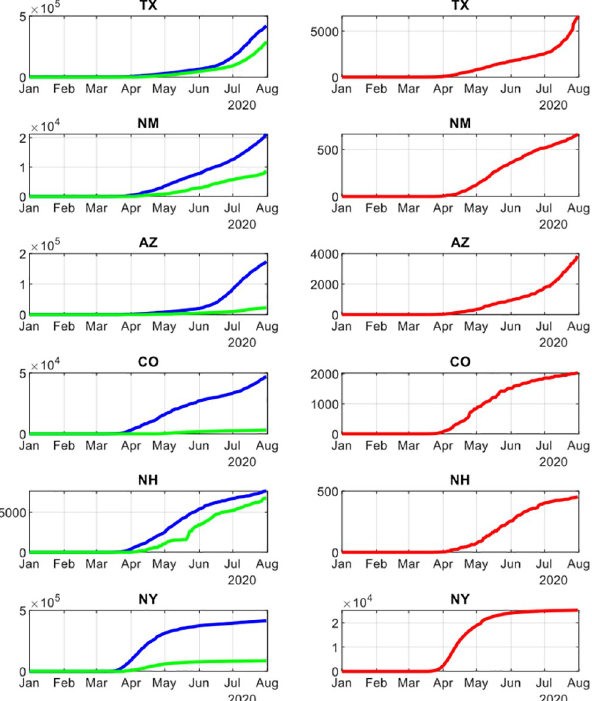
Fig 1. Time series plots for cumulative infection recovery and death for 6 states. Legend : Time series plot for all six states on cumulative confirmed infections, recovery and death. The left column has the cumulative infection (blue) and recovery cases (green) for each state from January to July 2020. The right column has the cumulative deaths for each state for the same period. The varying patterns between the states show up clearly.